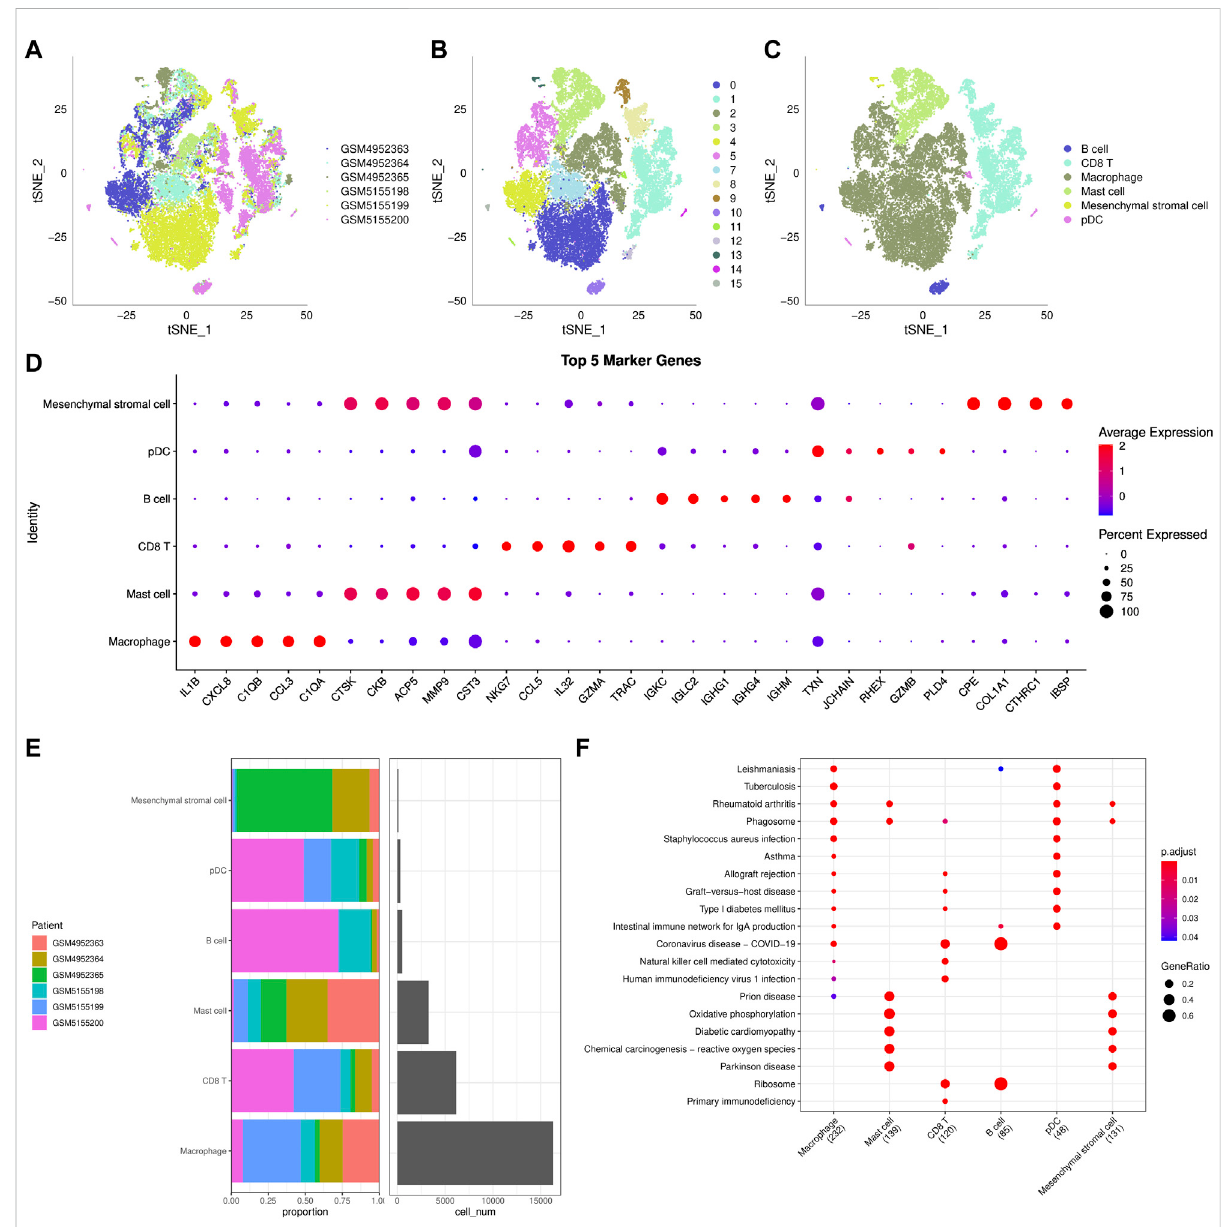
FIGURE 6 ScRNA-seq reveals cellular diversity and heterogeneity of osteosarcoma (A – C) : t-SNE plot of all the single cells, with each color coded for sample source (A) , cluster (B) , and immune cell type (C) . (D) : The bubble diagram showed the average expression of top5 marker genes in 6 kinds of immunecells. (E) :Thedistributionof6typesofimmunecellsineachsample. (F) :KEGGenrichmentanalysisbubblemapforthemarkergenesofeach type of immune